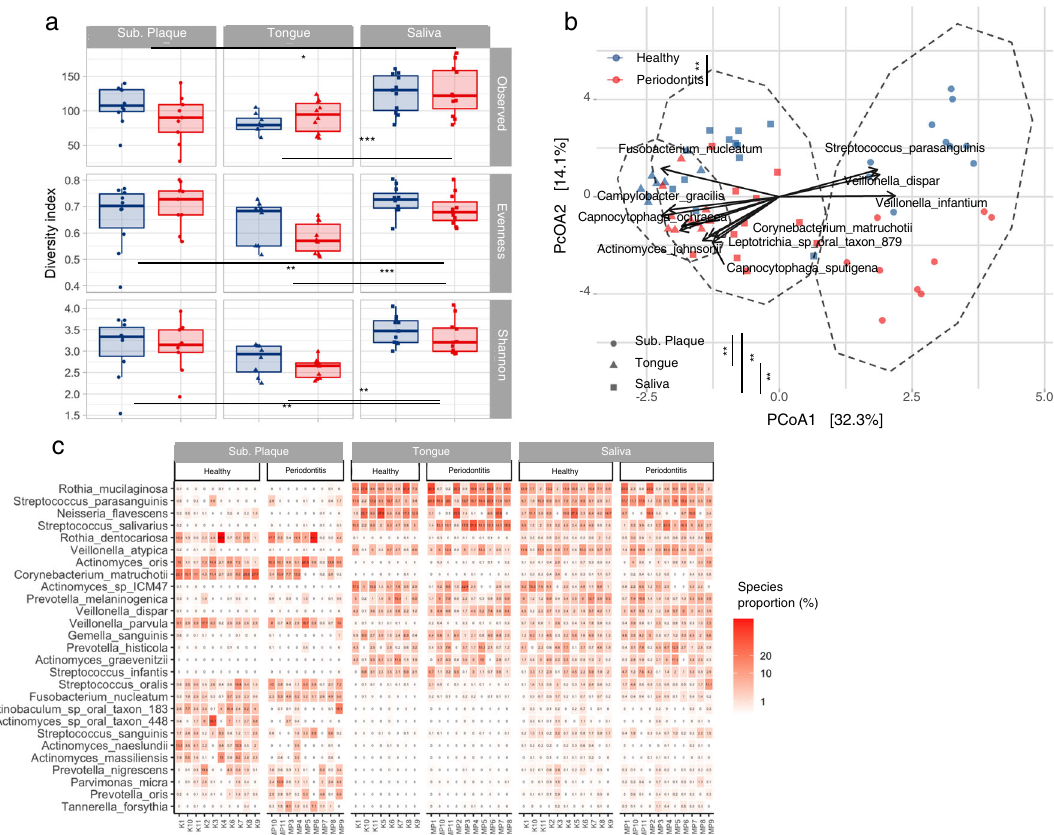
Fig. 1 Diversity and taxonomic composition of oral microbiota. a α -diversity patterns as measured by observed richness, Pielou ’ s evenness and Shannon diversity index. b β -diversity as summarized by Aitchison distance and visualized using PCoA ordination. c Top ten species identi fi ed in oral site x health status combinations (27 species in total). Color indicates heath status (blue: healthy controls versus red: periodontitis group), and shape re fl ects oral site. Signi fi cant differences were assessed using Kruskal – Wallis and PERMANOVAS tests for α and β -diversity, respectively. Signi fi cant FDR-adjusted p values were indicated as follows: *0.05 > p > 0.01 **0.01 > p > 0.001 *** p < 0.001. Boxplots display fi rst quartile, median, and third quartile and whiskers represent 1.5 times the interquartile range from the fi rst and third quartiles. The top 12 species signi fi cantly ( p < 0.05) correlated among the PCoA 1 and 2 axes were displayed using vegan::env fi t() function. Microbial taxonomic pro fi les are based on MetaPhlAn v3.0.1 — default